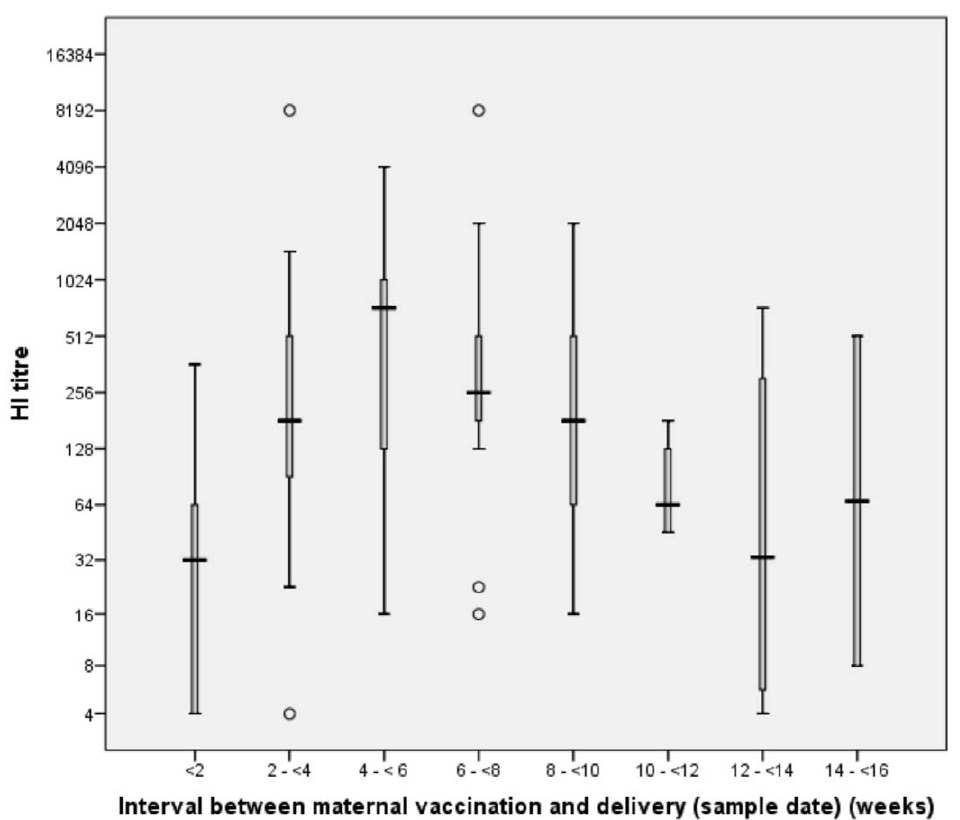
Figure 3. Boxplot GMT haemagglutinination inhibition titre by interval from maternal vaccination to delivery. (Titres are expressed as reciprocal of the dilution and are given on a log 2 scale.).